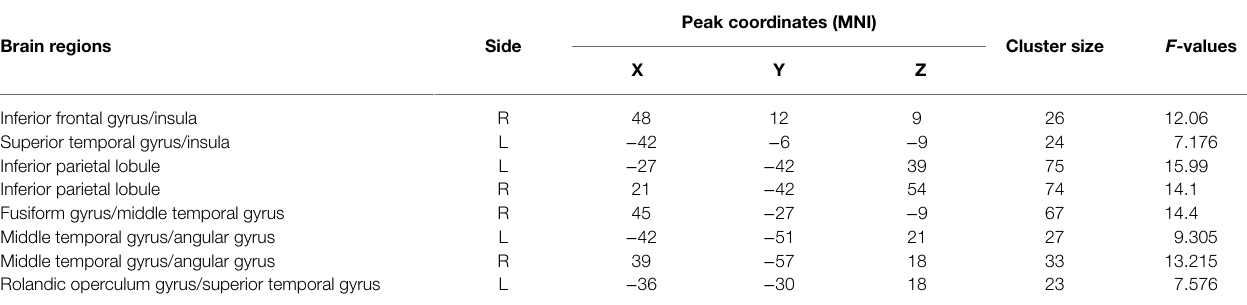
TABLE 2 | One-way ANOVA between the four groups for differences in ReHo values Brain areas. Brain regions Side